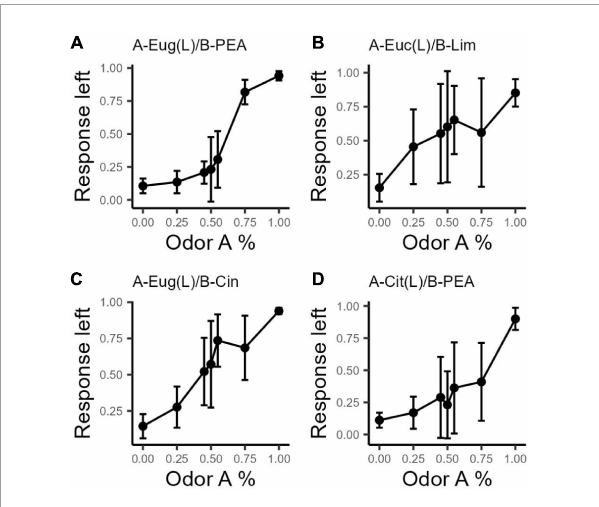
FIGURE1 Response intensity to the left port of each odor set. Response intensity is calculated as (n go left/N total) for each odor combination ratio (response left on vertical axis). Odorant A corresponds to the left port. Error bars are based on the standard deviation across subjects for each odor concentration ratio (horizontal axis). All odor sets show a logistic trend. Variances at extreme combination ratios (0A and 100A) are smaller than those of other combination ratios for all odor sets. (A) n = 6, OS1: Eug/PEA; (B) n = 10, OS2: Euc/Lim; (C) n = 7, OS3: Eug/Cin; (D) n = 8, OS4: